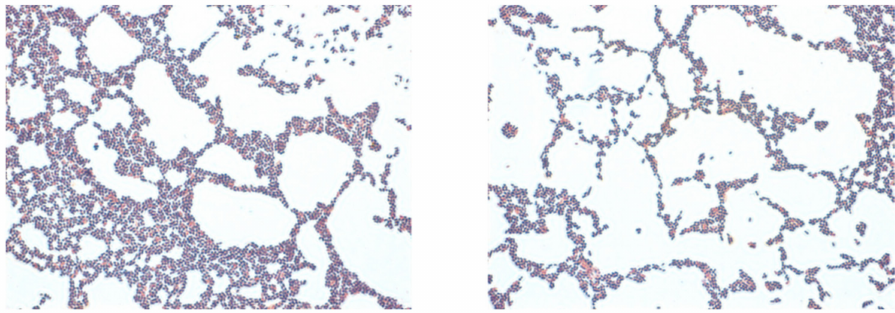
Figure 3. Gram stain of fermented liquor from shrimp waste at final process, observed at 100 × .